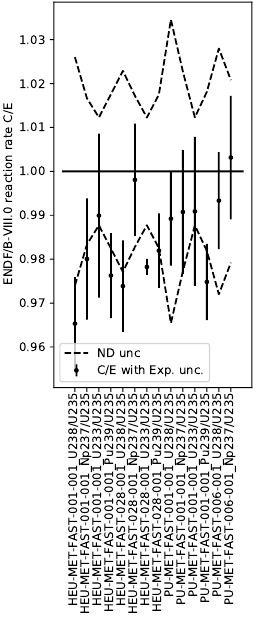
Figure 2. The same as Fig. 1 except for fission reaction rates in critical